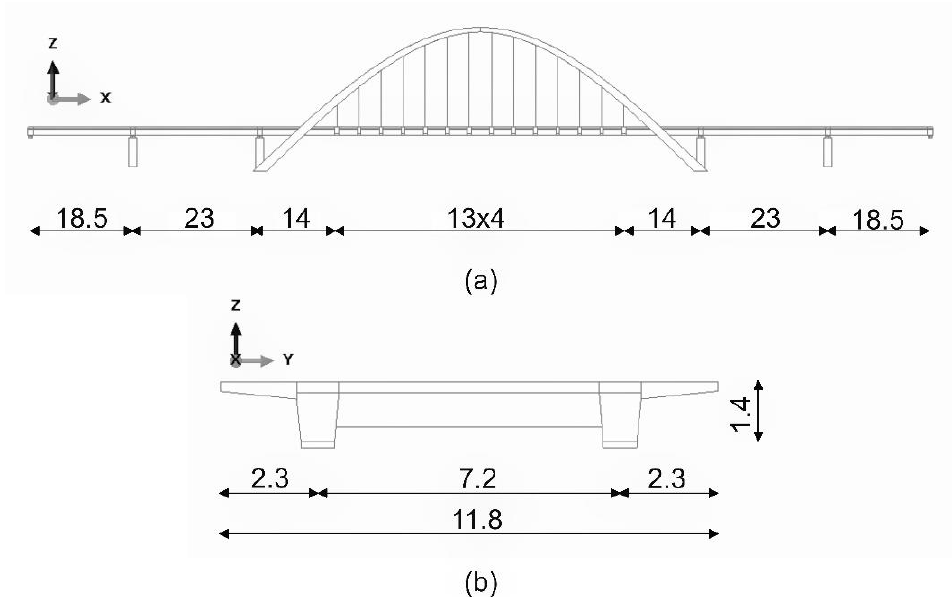
Figure 5. Bridge geometry and dimensions (m): ( a ) side view, ( b ) deck cross-section. Table 1. Bridge-building materials classes.